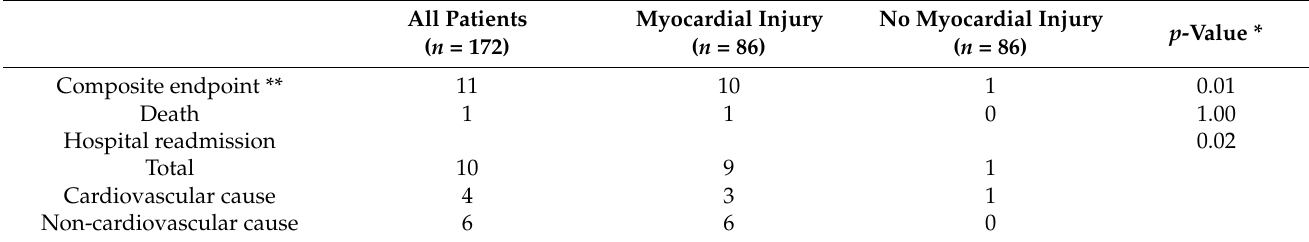
Table 2. Death and hospital readmission due to any cause at one year after hospital discharge.